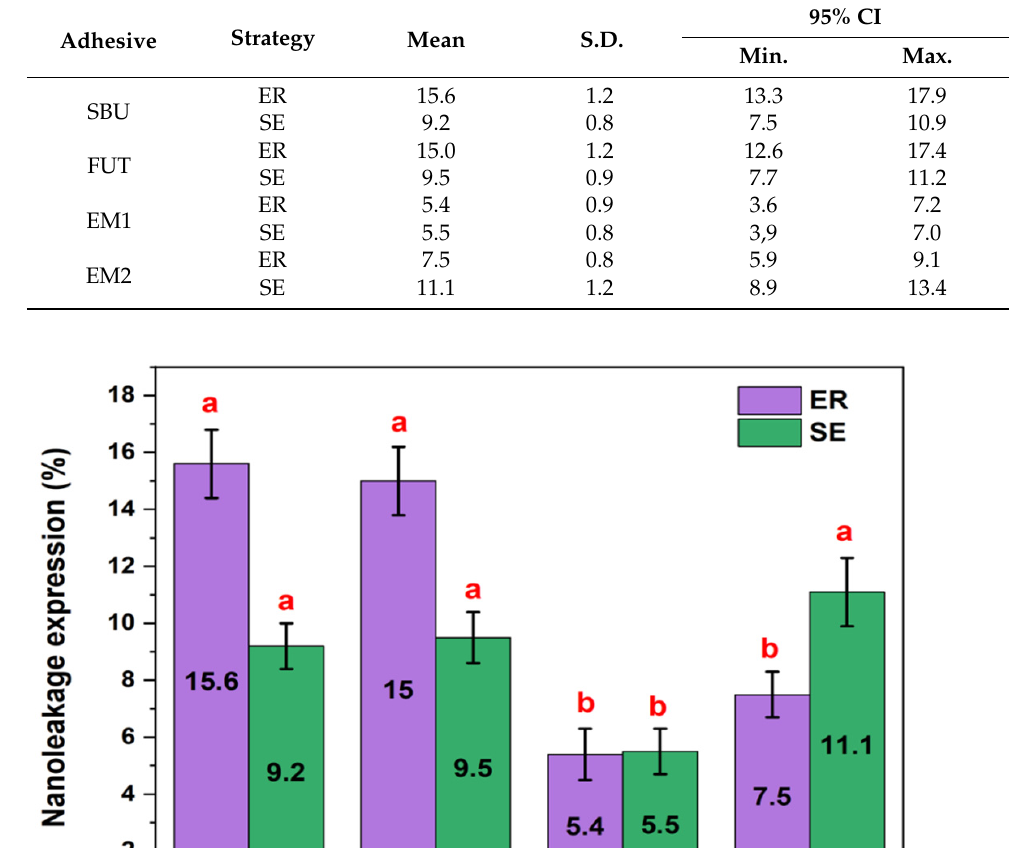
Table 8. Descriptive statistics for the mean results of nanoleakage (in %) for the different experi- mental groups, according to their adhesive strategy or application mode (ER/SE). CI represents confidence interval.